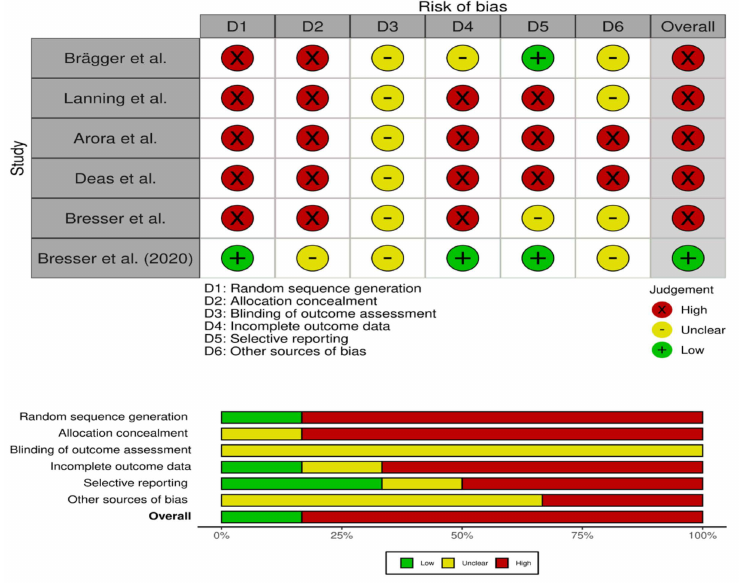
Figure 2. Summary of risk of